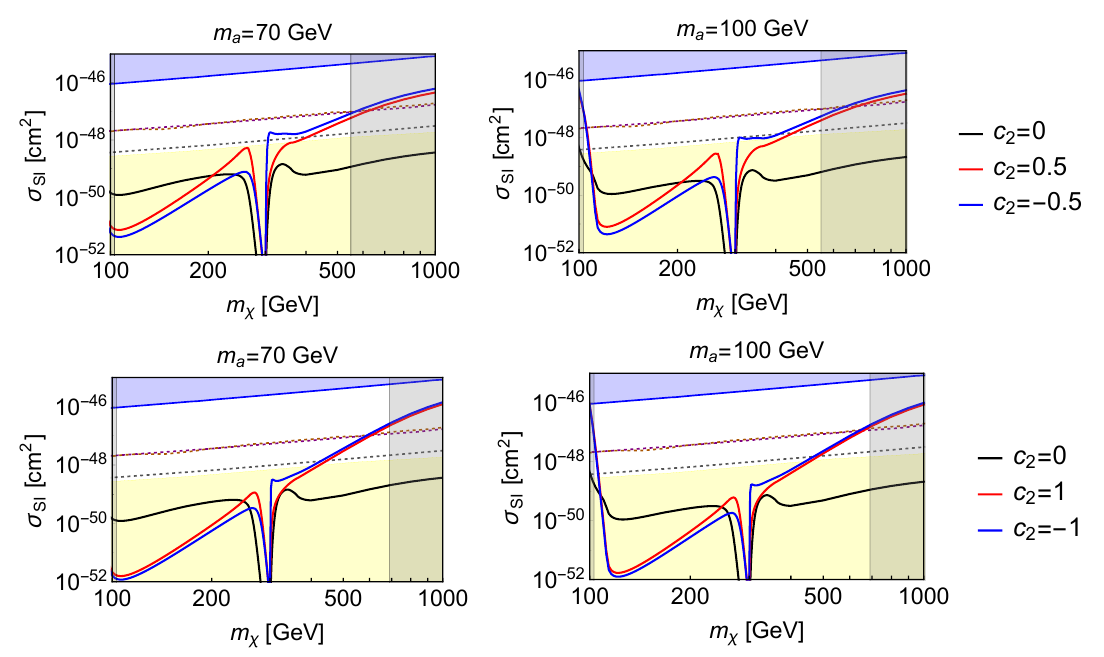
Figure 9 . The SI cross section at the four benchmark points. The upper panels show the case for j c 2 j = 0 : 5, and the lower for j c 2 j = 1. The left panels show the case for m a = 70 GeV, and the right for m a = 100 GeV. The other parameters are m A = 600 GeV, (cid:18) = 0 : 1, t (cid:12) = 10, c 1 = 0 for all the panels. The regions where g (cid:31) > 1 are shown as the gray region. The blue regions are excluded by the latest result of the XENON1T experiment [3]. The purple, brown, and gray dotted lines indicate the future sensitivities of the XENONnT [20], LZ [21], and DARWIN experiments [22], respectively. The yellow regions are below the neutrino (cid:13)oor